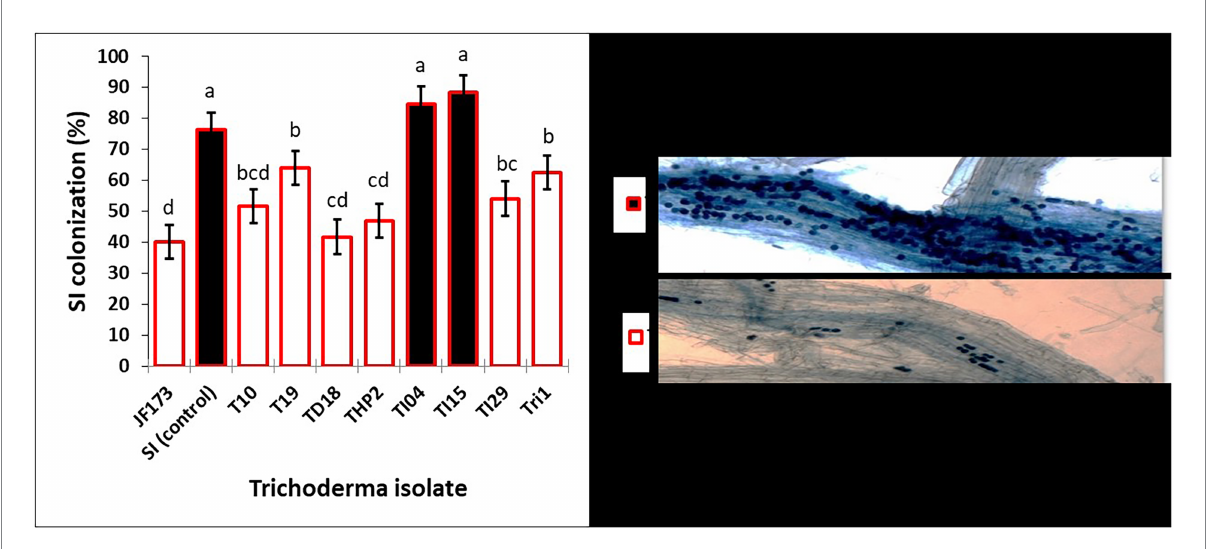
FIGURE 6 Effects of various degraded leaf-mixed Trichoderma spores on Serendipita indica colonization in rice seedling roots. Data are means ± SD ( n = 5). Bars without shared letters indicate significant differences according to Tukey’s HSD